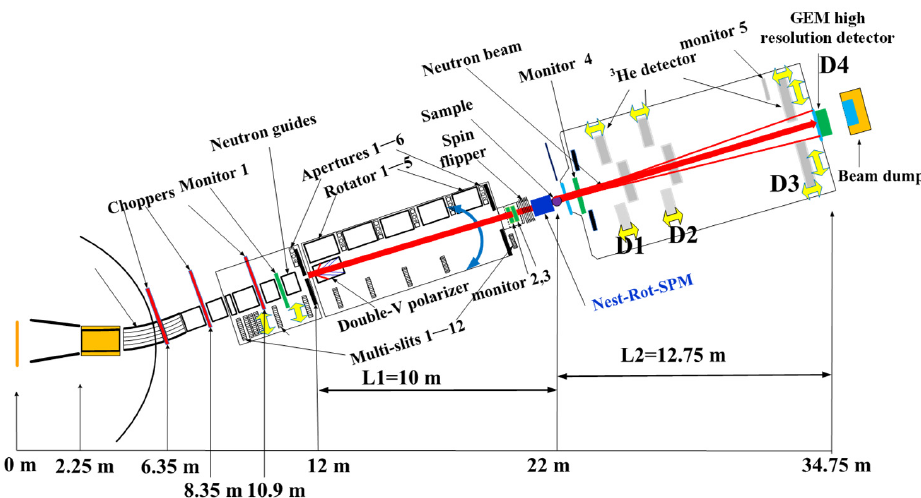
Figure 4. Layout of the components of the CSNS-VSANS instrument.